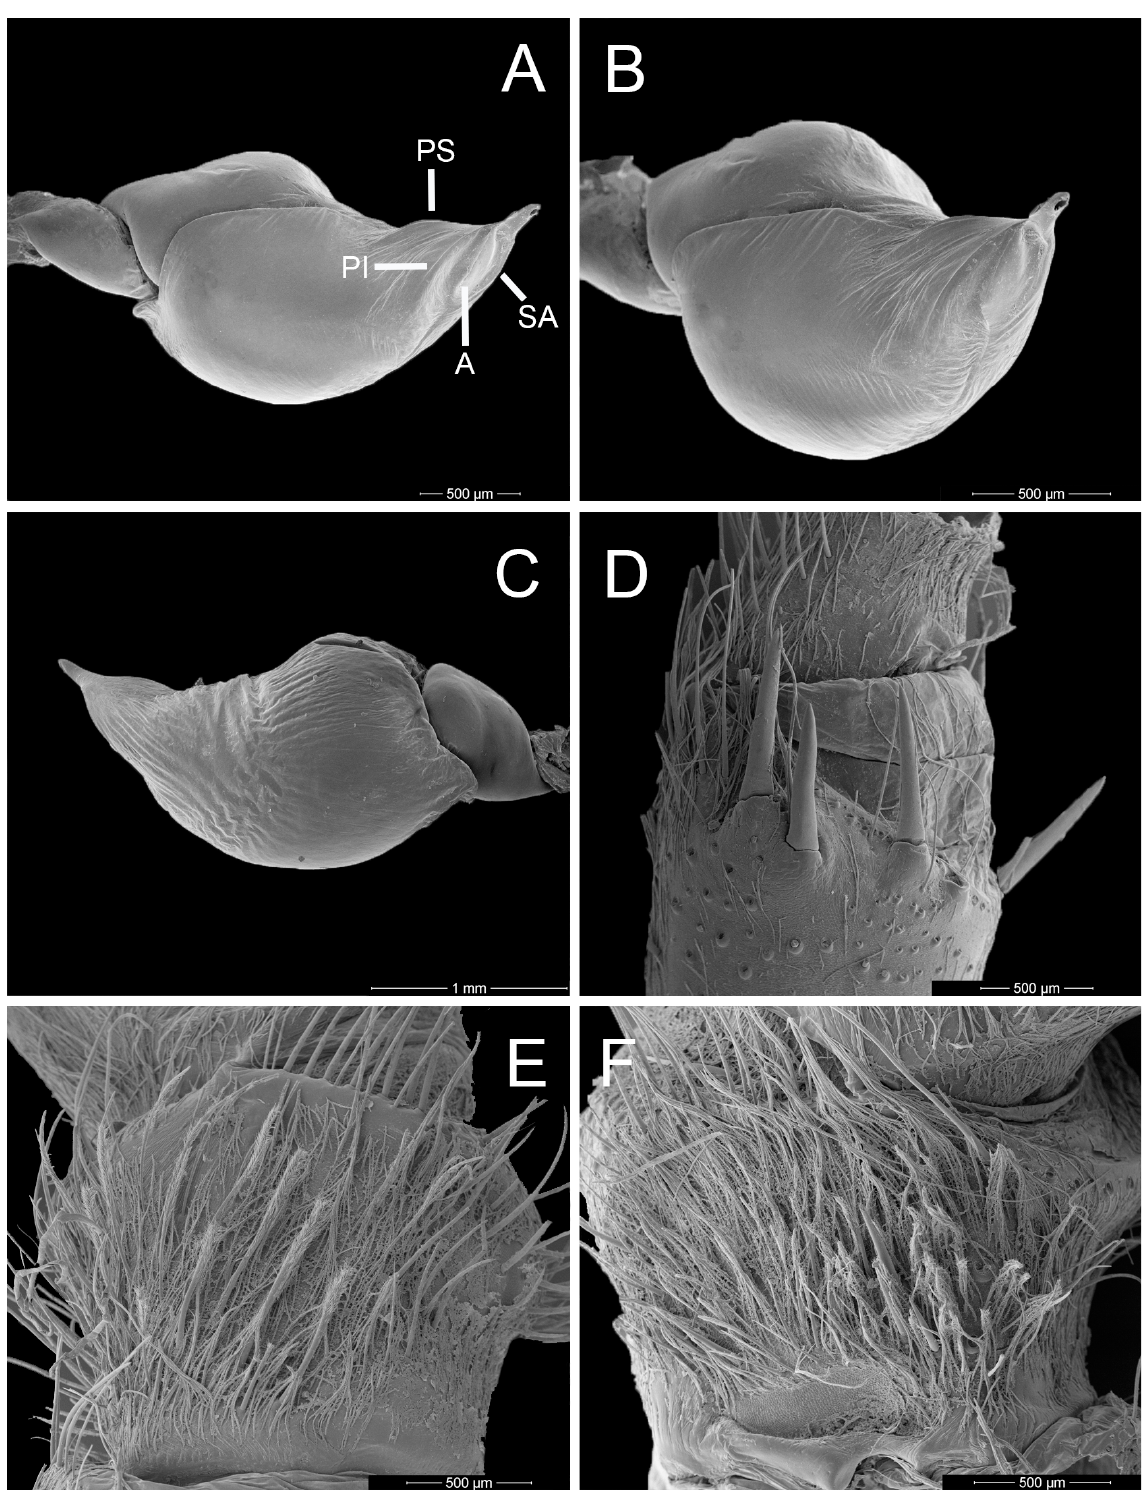
Fig. 20. Umbyquyra araguaia gen. et sp. nov., paratype, ♂, Serra do Lajeado, Tocantins, Brazil (IBSP 110473). A . Palp, prolateral. B . Anterolateral. C . Retrolateral. D . Tibial apophysis, retrolateral. E . Stridulatory organ, palp trochanter. F . Trochanter I. Abbreviations: see Material and